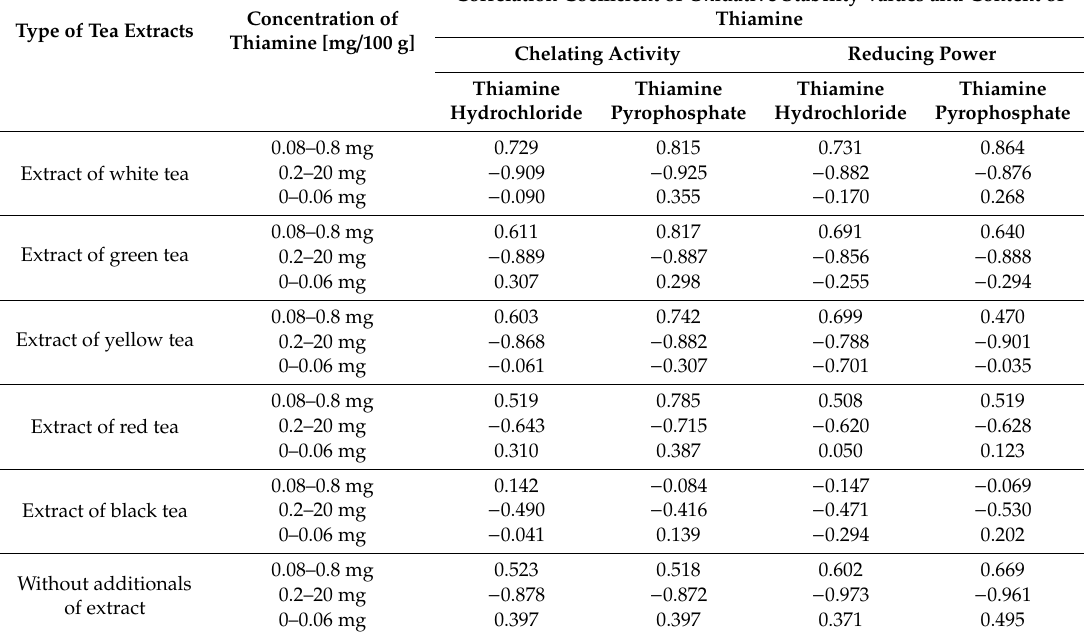
Table 3. Correlation coe ffi cients between the chelating activity and the reducing power of ethanol tea extracts and the content of thiamine pyrophosphate and thiamine pyrophosphate.